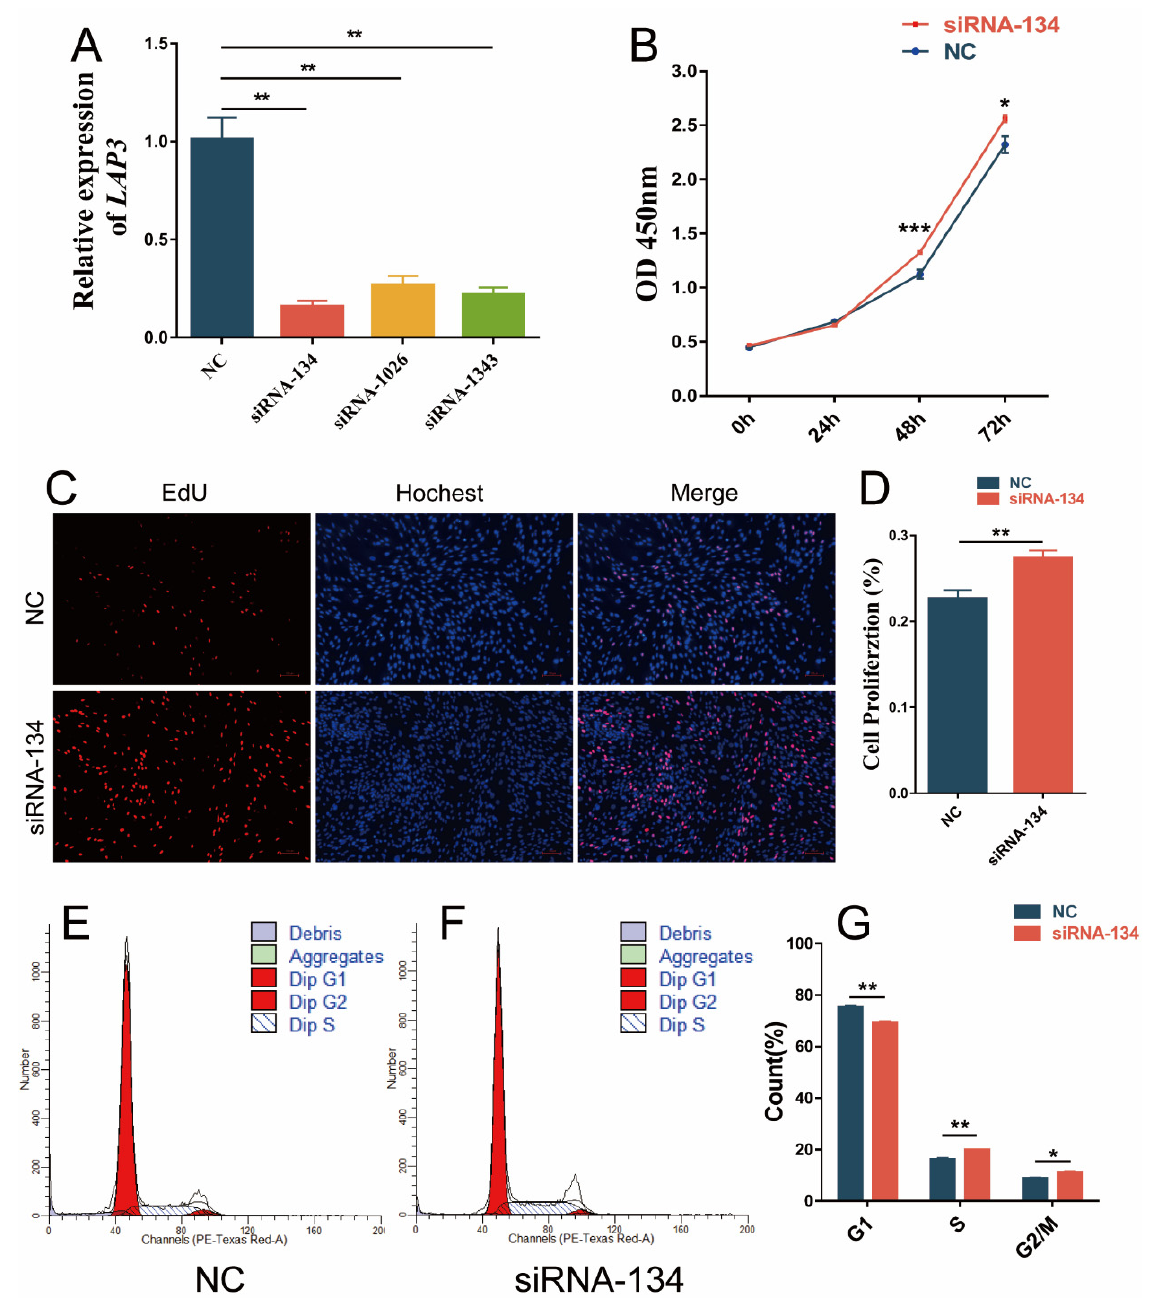
Figure 3. Effects of LAP3 knockdown on embryonic myoblasts proliferation. ( A ) Interference efficiency of LAP3 mRNA expression levels detected by RT-PCR in embryonic myoblasts transfected with siRNA-LAP3 or control. ( B ) CCK-8 assay of embryonic myoblasts transfected with siRNA-134 or control at 0 h, 24 h, 48 h, and 72 h. ( C ) EdU cell proliferation assay of embryonic myoblasts transfected with siRNA-134 or control (100 × ). ( D ) Cell proliferation rate of embryonic myoblasts transfected with siRNA-134 or control. ( E , F ) Flow cytometric measurement of DNA content using propidium iodide (PI) staining of embryonic myoblasts transfected with siRNA-134 or control. ( G ) Ratio of embryonic myoblasts at different stages of cell cycle transfected with siRNA-134 or control. * p < 0.05, significant difference; ** p < 0.01, or *** p < 0.001 extremely significant difference according to Student’s t -test; data are shown as mean ± SEM, n = 3 biological replicates.